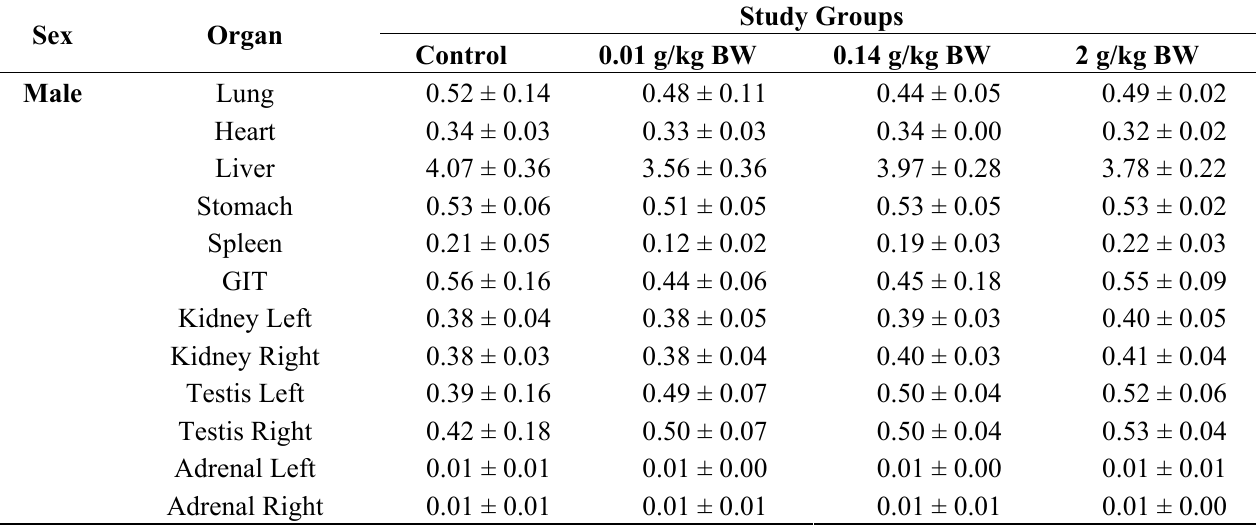
Table 4. The relative organ weight per 100 g body weight recorded at the end of the study from male and female rats treated with C. papaya extract measured during the 28 days sub-acute toxicity